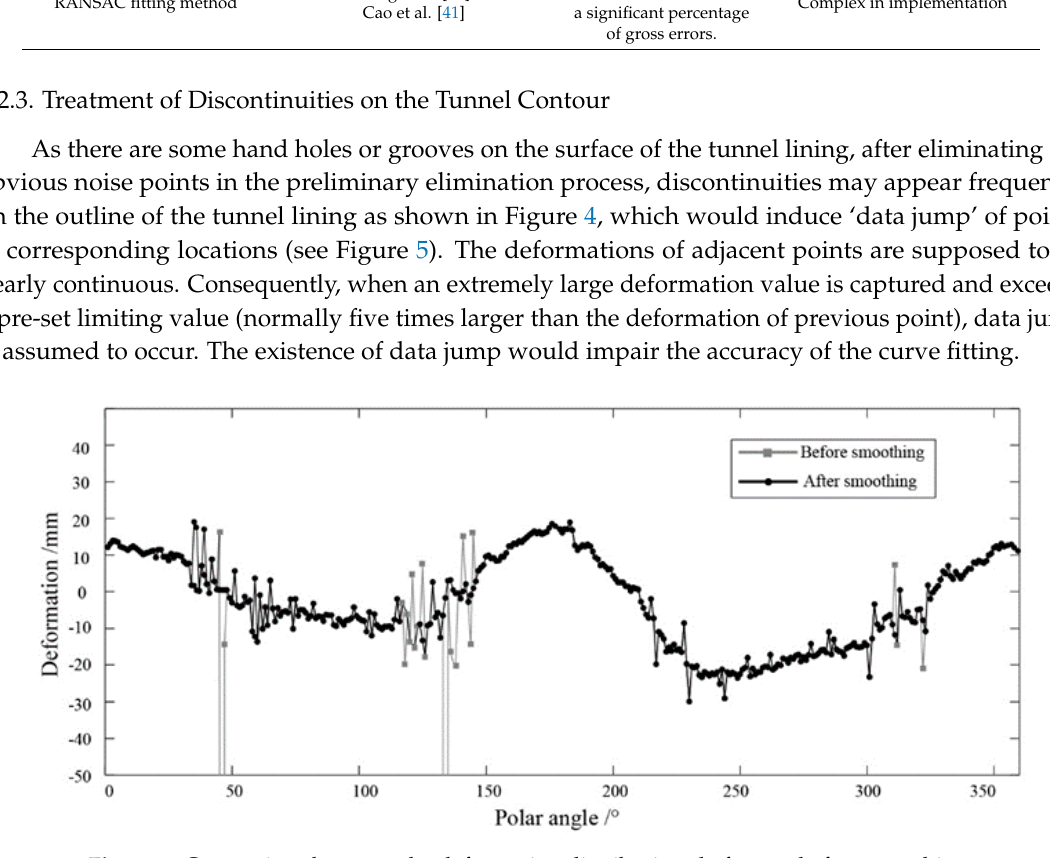
Figure 5. Comparison between the deformation distributions before and after smoothing.